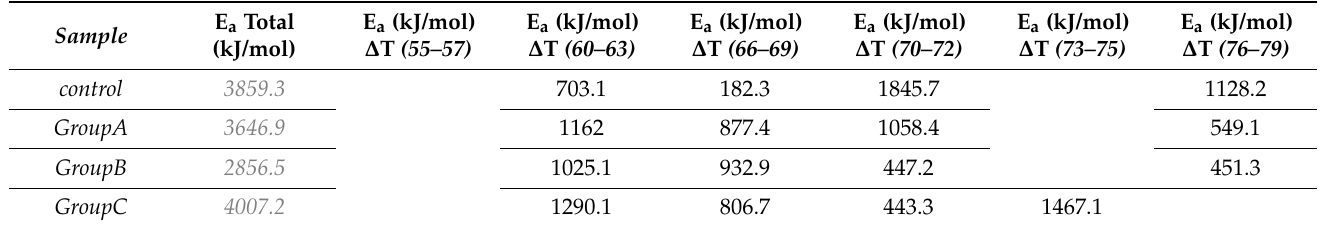
Table 2. Contribution of activation energies (gray numbers) resulted by the analysis of deconvolved data from Figure 1 representing different temperature ranges of the peaks ( ∆ T). (The empty fields indicating missing data as the model fitting does not work properly with small peaks, and thus cannot result applicable values, recently